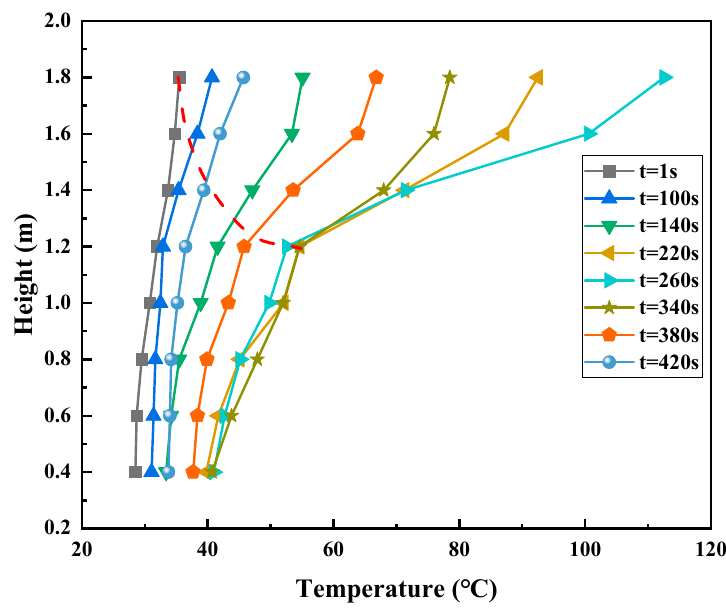
Figure 7. Vertical temperature change in 1# thermocouple tree ( V s = 2.058 m 3 /s ) . Figure 8 shows the variation in the vertical average temperature at different positions in the cabin. The average temperature here is the average temperature of all thermocouples vertically at this position. It can be seen from the figure that the temperature in the middle part of the cabin was obviously higher than the temperature at the position of the manhole and the entrance of the ladder. Figure 9 shows the variation law of the vertical average temperature at position 1 under different supply air volume conditions. With the increase in air supply air volume, the average temperature in the cabin shown a gradually decreasing trend.